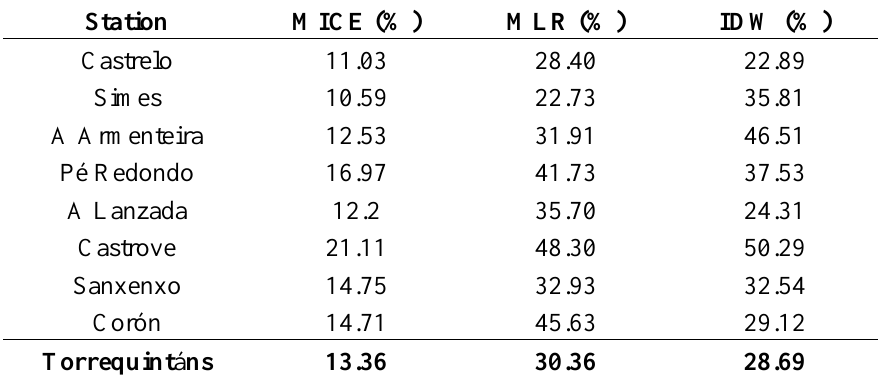
Table 10. Results of the three models in terms of